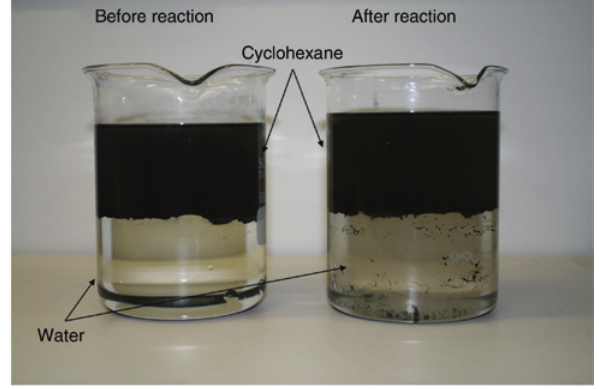
Figure 6: Distribution of the Ru-C catalyst between the aqueous and organic phases before and after dehydration-hydrogenation